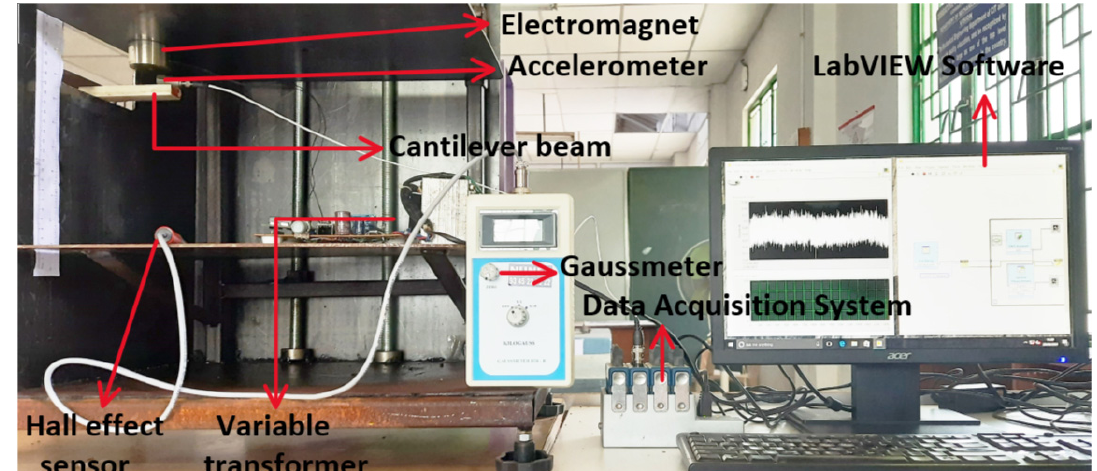
Figure 5. Experimental setup for vibration response of cantilever structure.